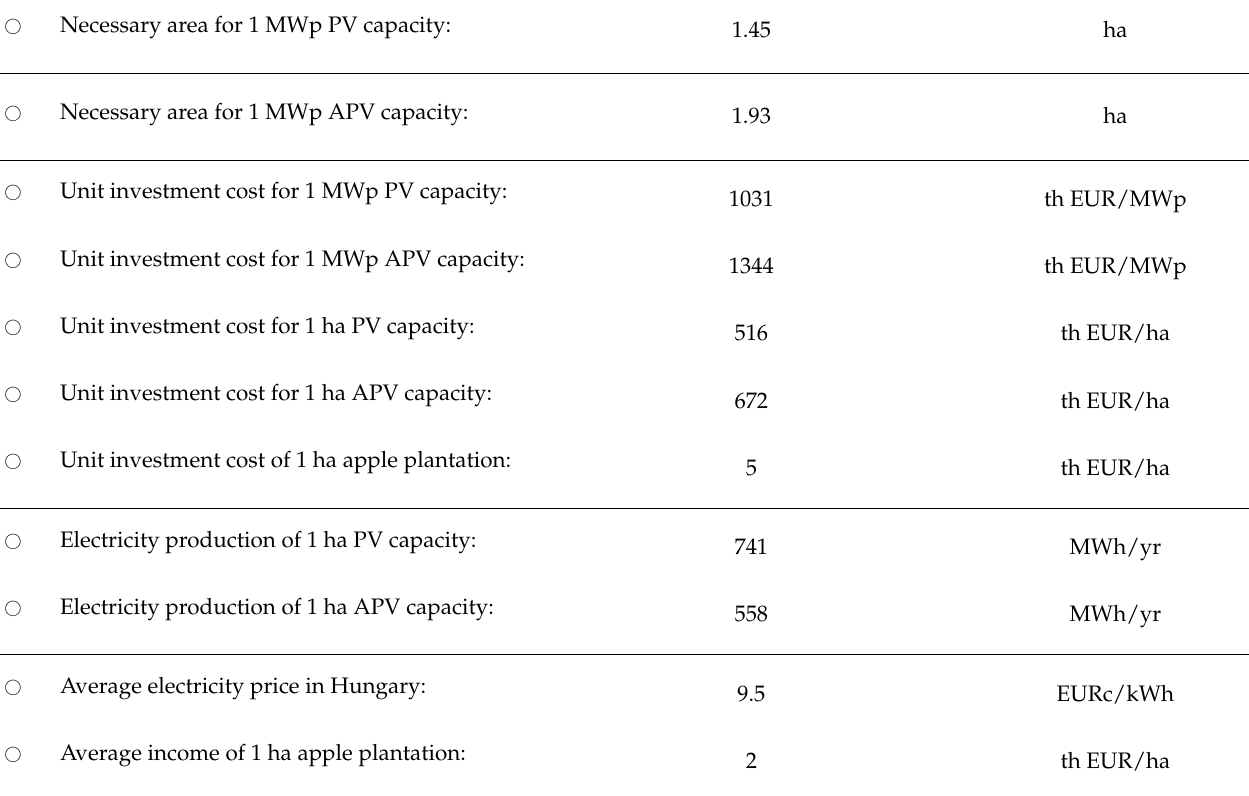
Table 2. The baseline for an economic comparison analysis for APV and PV-GM